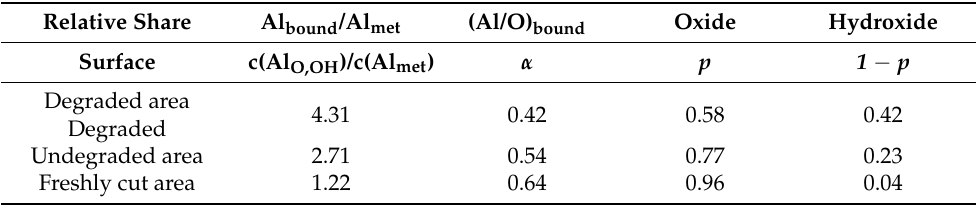
Table 3. Calculated surface composition regarding shares of Al bound in the oxide and hydroxide vs. Al met , ratio of Al bound in the oxide and hydroxide vs. oxygen bound in those compounds and the Al 2 O 3 in Al oxides and hydroxides ( p ).